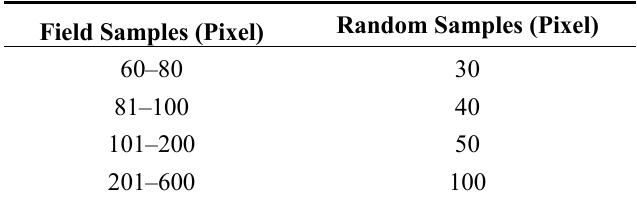
Table 2. Validation dataset (number of